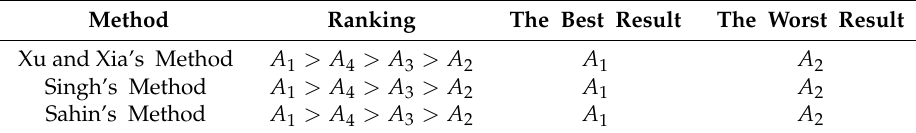
Table 3. Relationships between presenting methods and our method